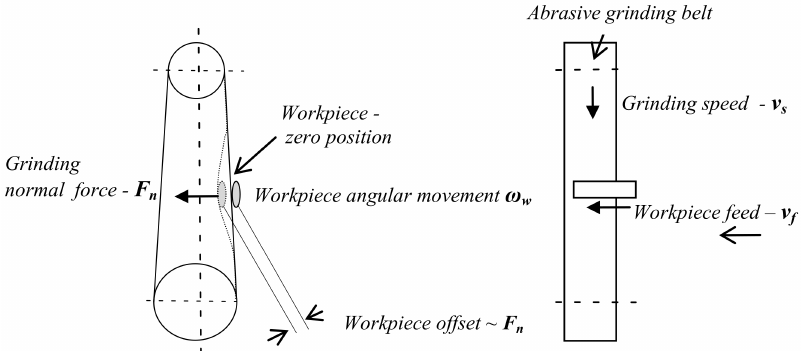
Figure 10. Robotic belt grinding